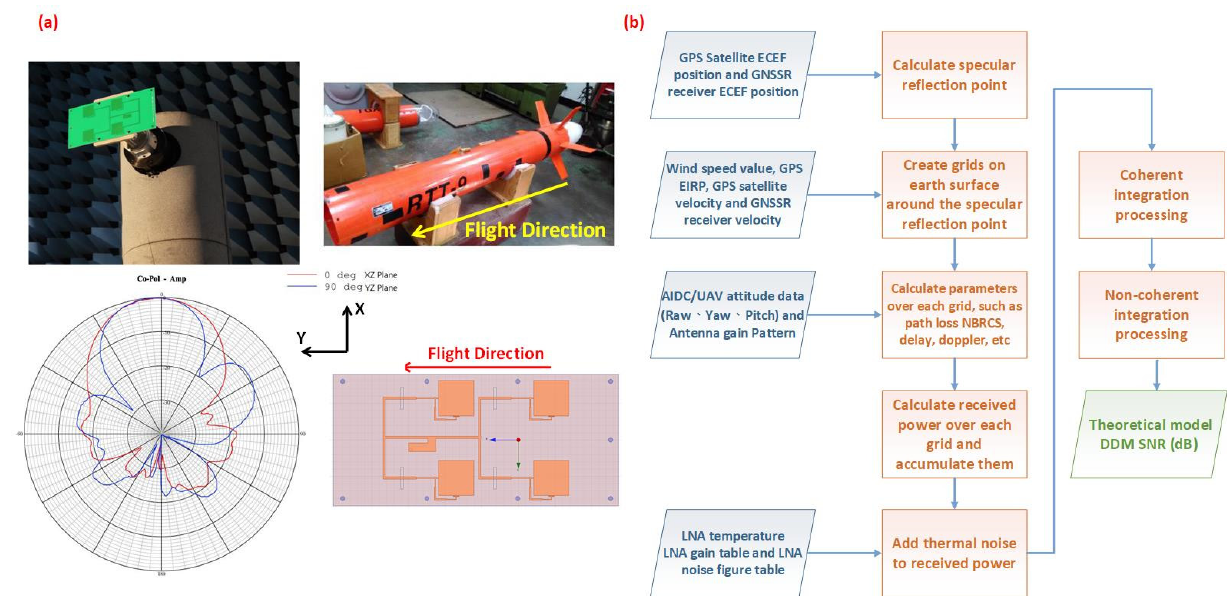
Figure 17. ( a ) Antenna gain pattern and setup configuration ( b ) Link budget analysis flowchart.